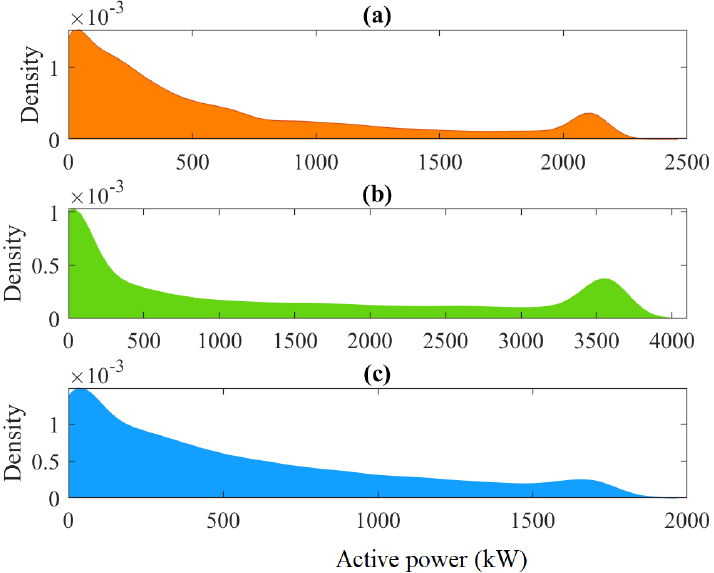
Figure 6. PDF of the used wind power time-series data from ( a ) France, ( b ) Turkey, and ( c )